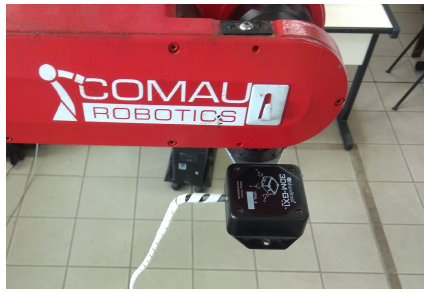
Figure 2. Experimental setup using the MicroStrain 3DM-GX1 (cid:114) IMU and the Comau Smart Six (cid:114)